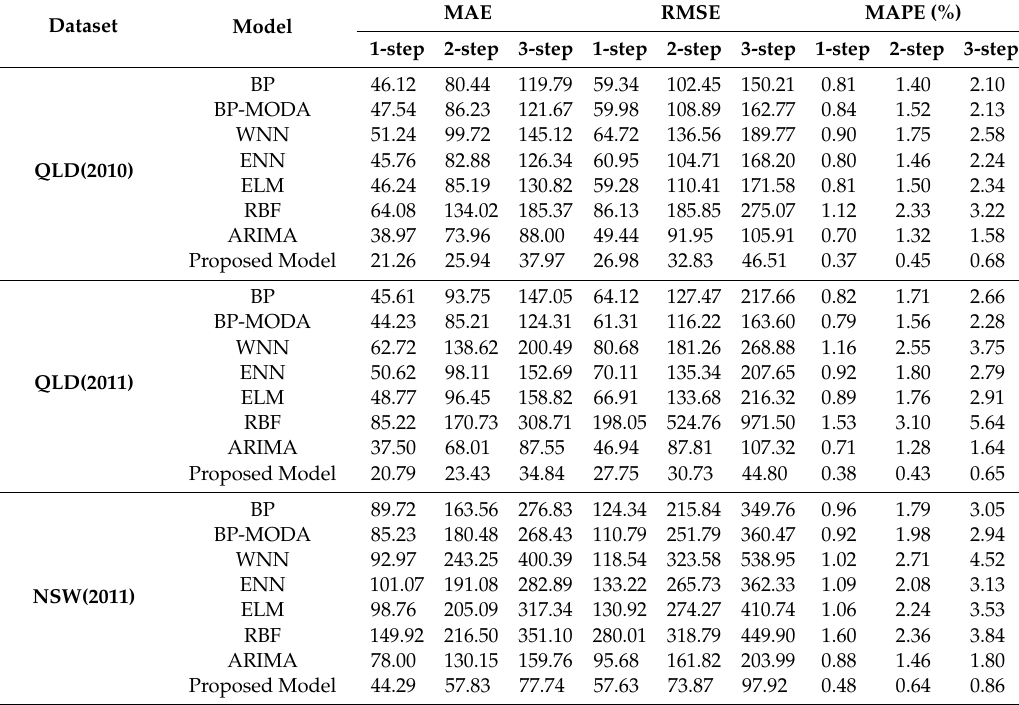
Table5. Comparisonofforecastingperformanceofcombinedmodelandsomeclassicindividualmodels.